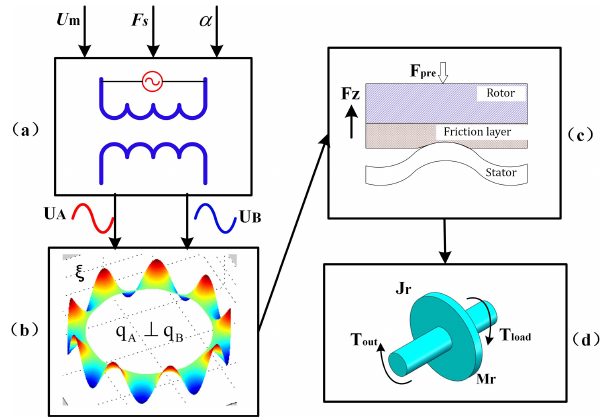
Figure 1. The block diagram of the TWUSM: (a) the driver; (b) the vibration and traveling wave of the stator; (c) the stator–rotor con- tact; (d) the rotor with the externally applied load.